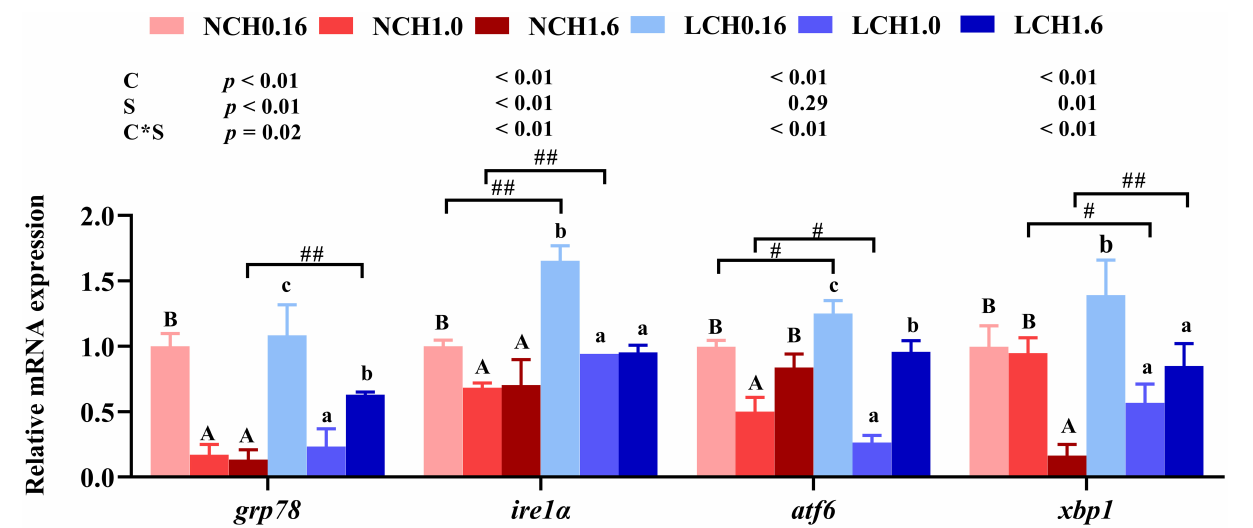
FIGURE 5 | Effects of different dietary cholesterol level and water salinity on the relative mRNA expression involved in endoplasmic reticulum stress in juvenile black seabream ( Acanthopagrus schlegelii ). The group of NCH0.16 was set as the reference group, and the mRNA expression levels of target genes were normalized relative to the expression of β -actin . Values are means ( n = 3) with standard errors represented by vertical bars. Two-way ANOVA P -values are shown in each panel, with “C” representing effects of dietary cholesterol levels, “S” representing effects of salinity, and “C*S” representing interaction between dietary cholesterol levels and salinity. “ABC” representing significant ( P < 0.05) difference between dietary cholesterol levels in normal water salinity (23 psu) and “abc” representing significant ( P < 0.05) difference between dietary cholesterol levels in low water salinity (5 psu) by performing one-way ANOVA. “#” representing significant ( P < 0.05) difference between water salinity with same dietary cholesterol level and “##” representing highly significant ( P < 0.01) difference between water salinity with same dietary cholesterol level by performing t -test. grp78 , glucose regulated protein 78; ire1 α , inositol requiring enzyme 1 α ; atf6 , activating transcription factor 6; xbp1 , X-box binding protein